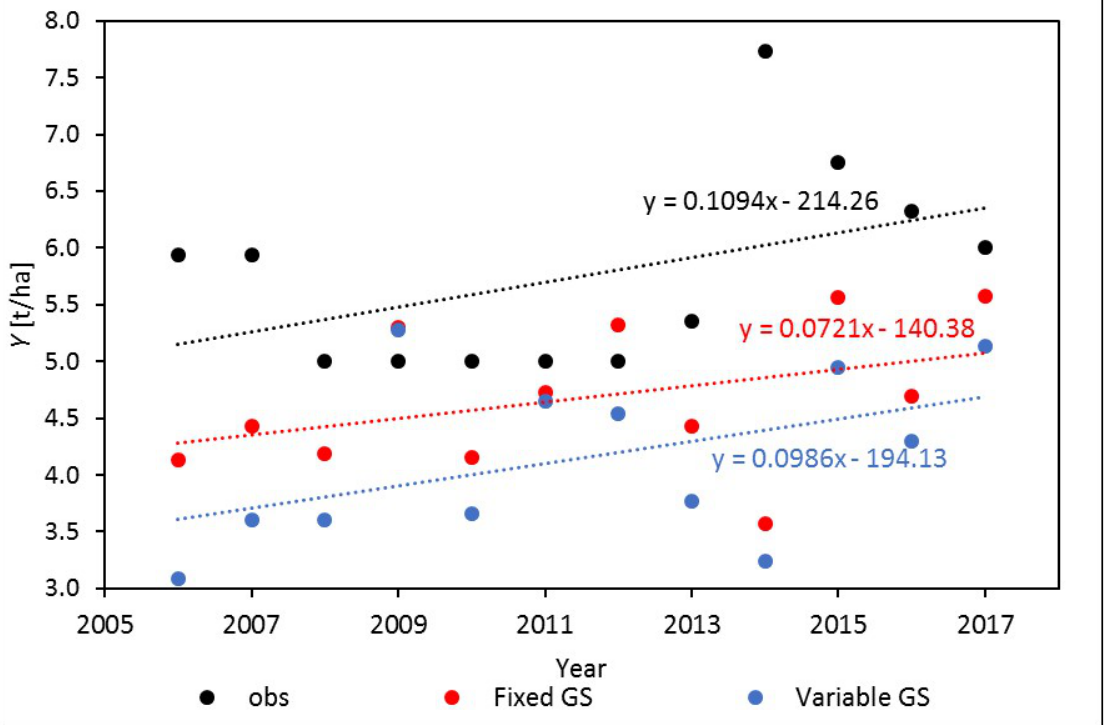
Figure 4. Trend in specific productivity Y: observed values of Y of permanent and other pastures are in black, while the result of simulations are reported in red and blue, considering fixed and variable GS, respectively.